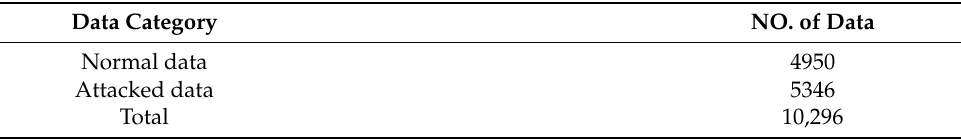
Table 3. Our UAV dataset for model